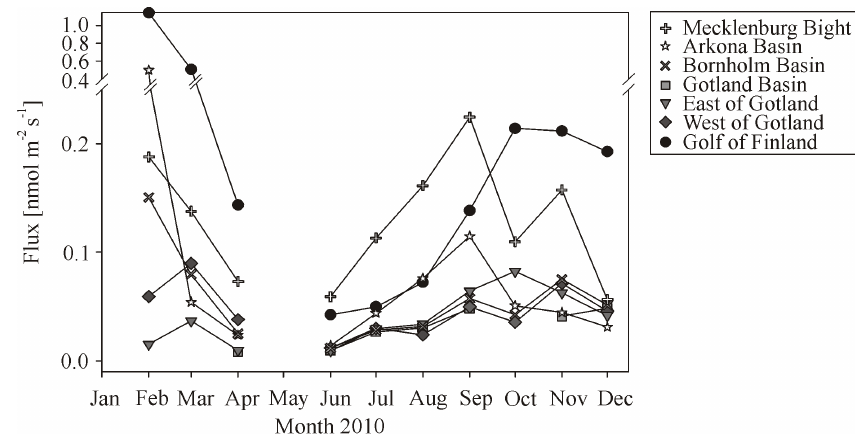
Fig. 8. Methane fluxes F [nmolm − 2 s − 1 ] calculated as monthly average for selected areas of the Baltic Sea using the equation described in Wanninkhof et al. (2009). Atmospheric methane data from the NOAA station in Poland were used for the calculation of the equilibrium concentration.